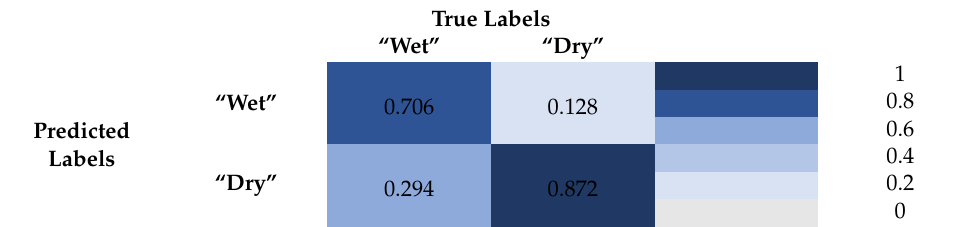
Table 5. Confusion matrix for test set 1 when results were compared with SAS PSREU data.